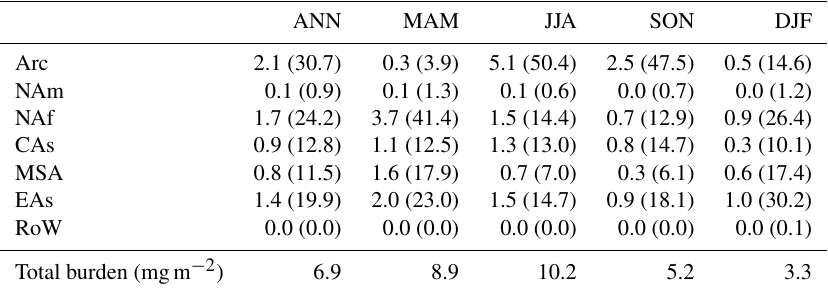
Table 2. Annual and seasonal mean Arctic (60–90 ◦ N) dust burden (mgm − 2 ) from different sources. The numbers in parentheses are the relative contributions (%) of each source to the total Arctic dust burden. The total Arctic dust burden is shown in the last